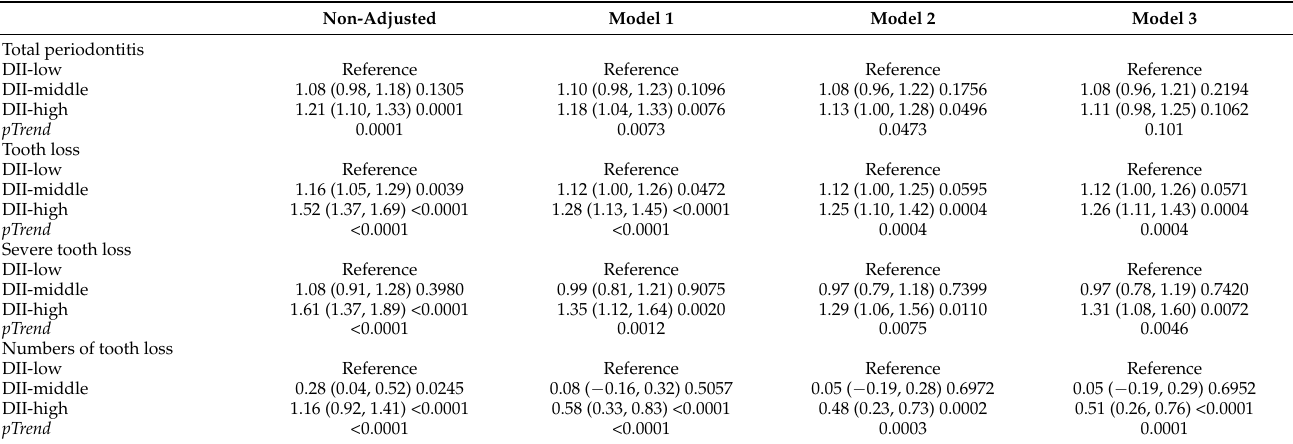
Table 2. Risk of periodontal outcomes according to DII tertile groups (N =